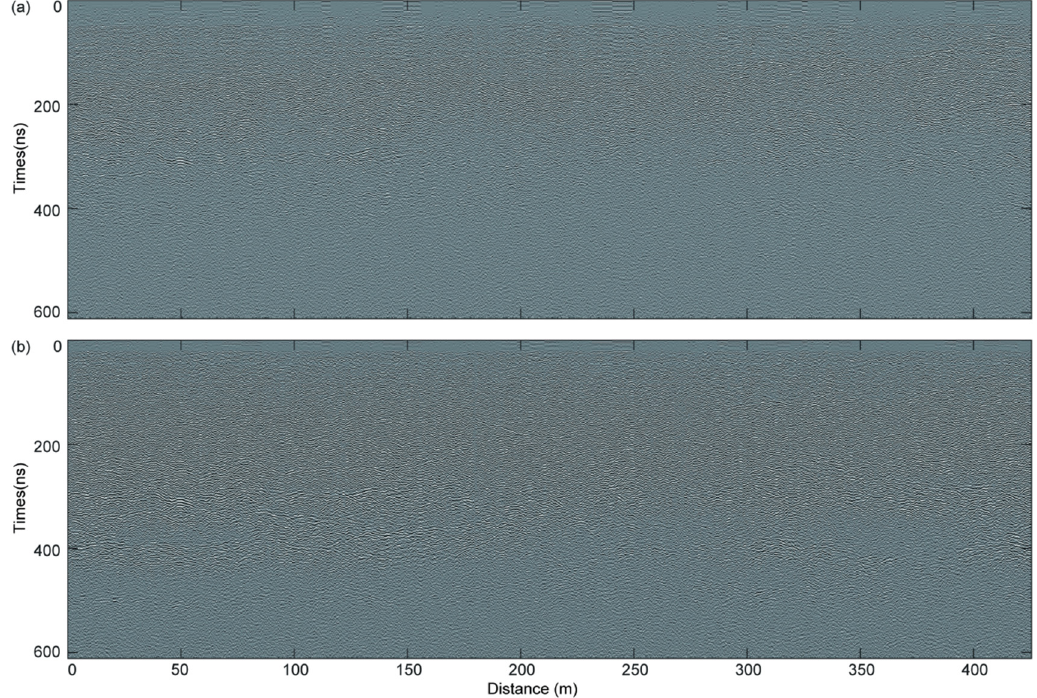
Figure 2. High-frequency LPR profile along the track of rover Yutu-2 after the series of data processing. ( a ) The CH-2A data; ( b ) the CH-2B data.